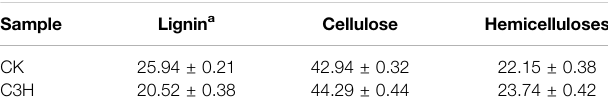
TABLE 2 | Monosaccharide content of the KOH-extracted